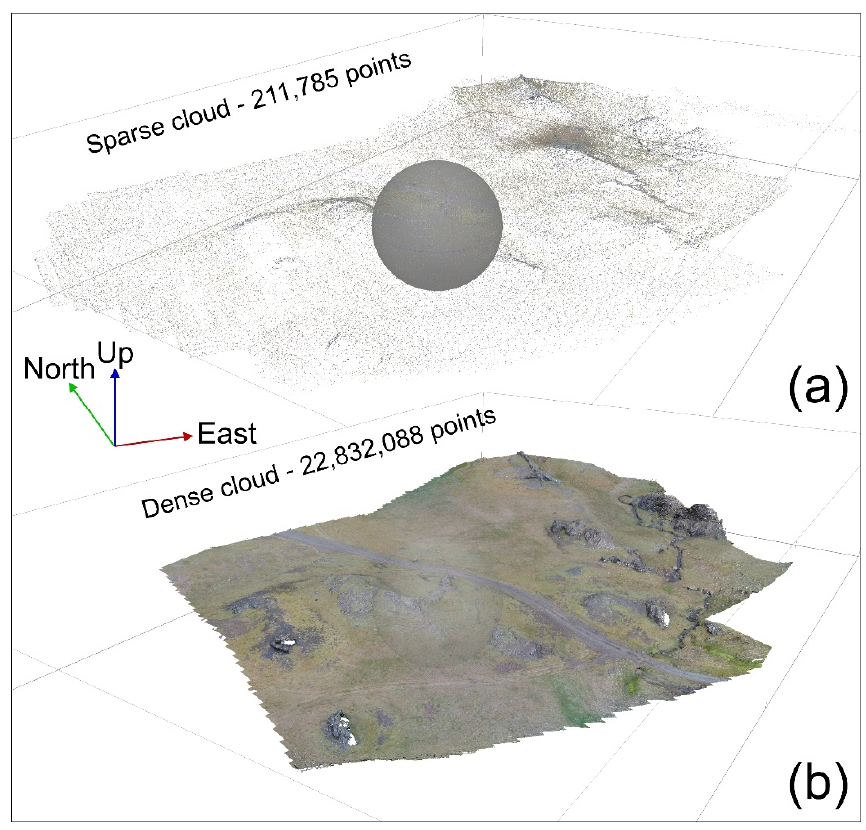
Figure 5. ( a ) Example of sparse and ( b ) dense cloud obtained by applying the above-mentioned workflow, including a “Filter by confidence” tool.